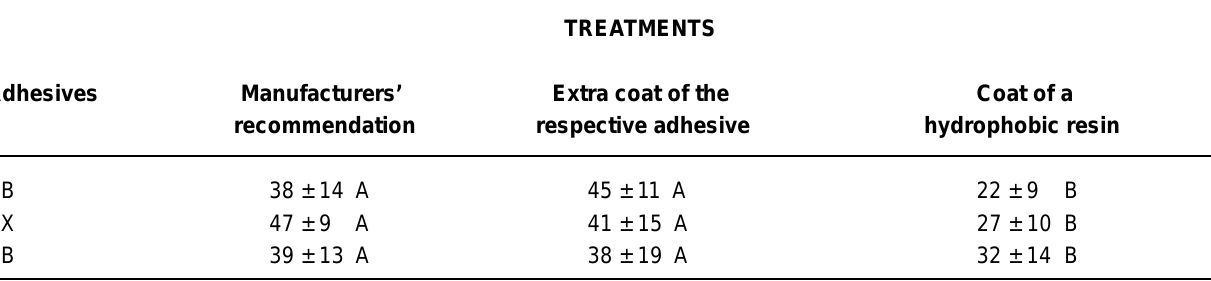
Values (Mean ± SD) are expressed as a percentage of the maximum permeability (acid-etched dentin). Groups identified by different letters were statically different